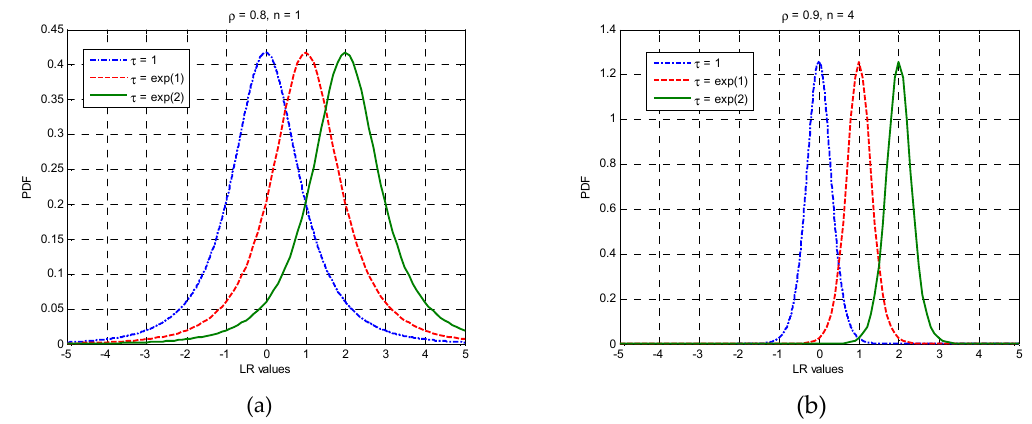
Figure 1. Theoretical probability density functions (PDFs) of log-ratio (LR) statistics with varying parameters: ( a ) fixed n = 1 and ρ = 0.8 for different values of τ ; ( b ) fixed n = 4 and ρ = 0.9 for different values of τ .